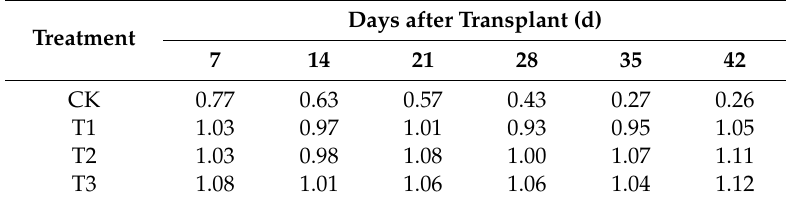
Table 4. Nitrogen nutrition index (NNI) in pakchoi at di ff erent nitrogen treatments.